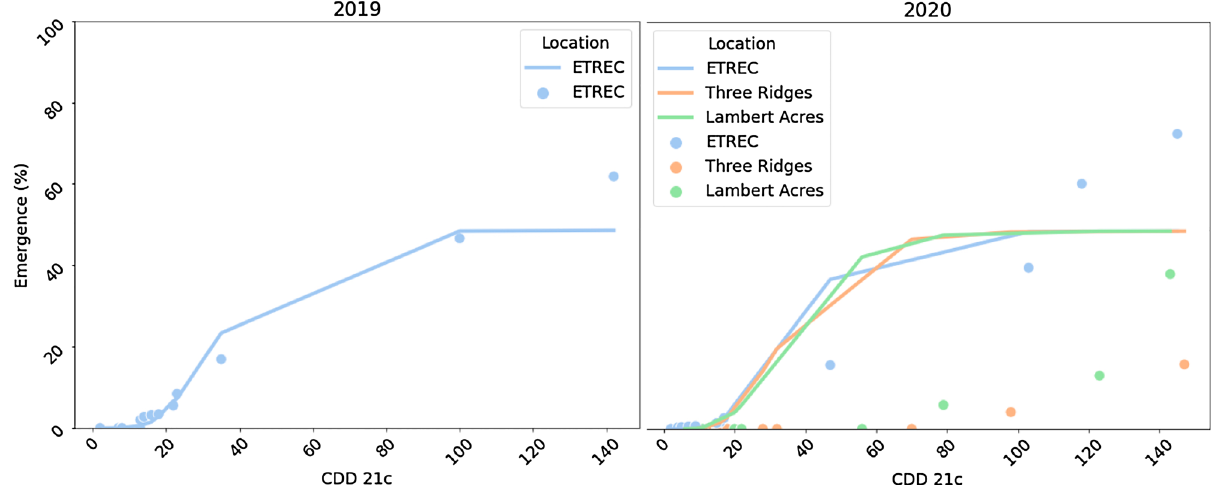
Figure 1. Gompertz function fit to early season (0 to 50% yearly maximum) P. annua emergence data collected at the East Tennessee AgResearch & Education Center—Plant Sciences Unit (Knoxville, TN) in 2019 and 2020, as well as Lambert Acres Golf Course (Alcoa, TN) and Three Ridges Golf Course (Knoxville, TN) in 2020. Emergence data were collected weekly with observations were regressed over cooling degree days (CDD 21C ) with accumulation beginning at the summer solstice using a 21 °C base temperature. Colored circles represent actual observations whereas the solid line represents model predictions. Measures of model fit for each location and year are presented in Table 1.